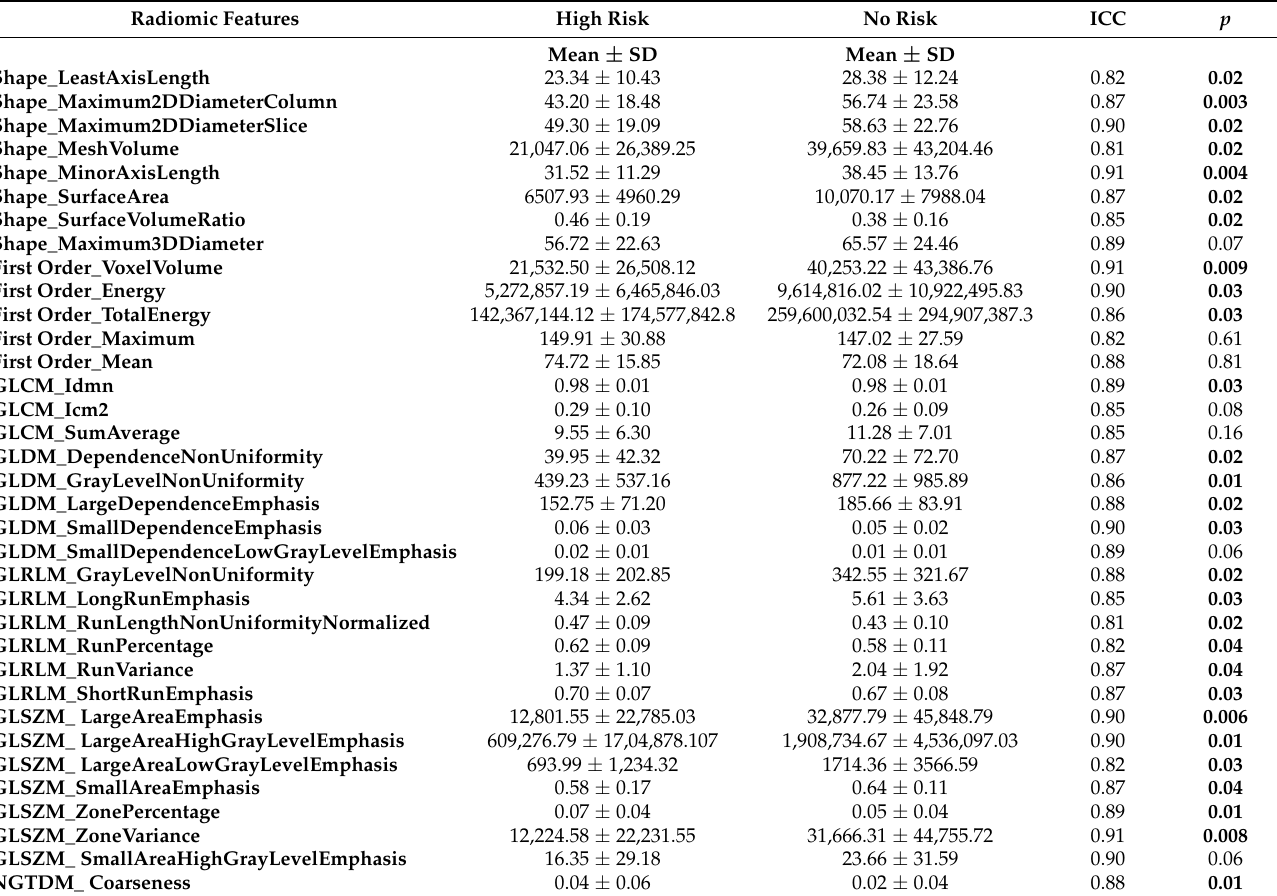
Table 2. Stable radiomic features in comparison between High-risk and No-risk patients. Radiomic